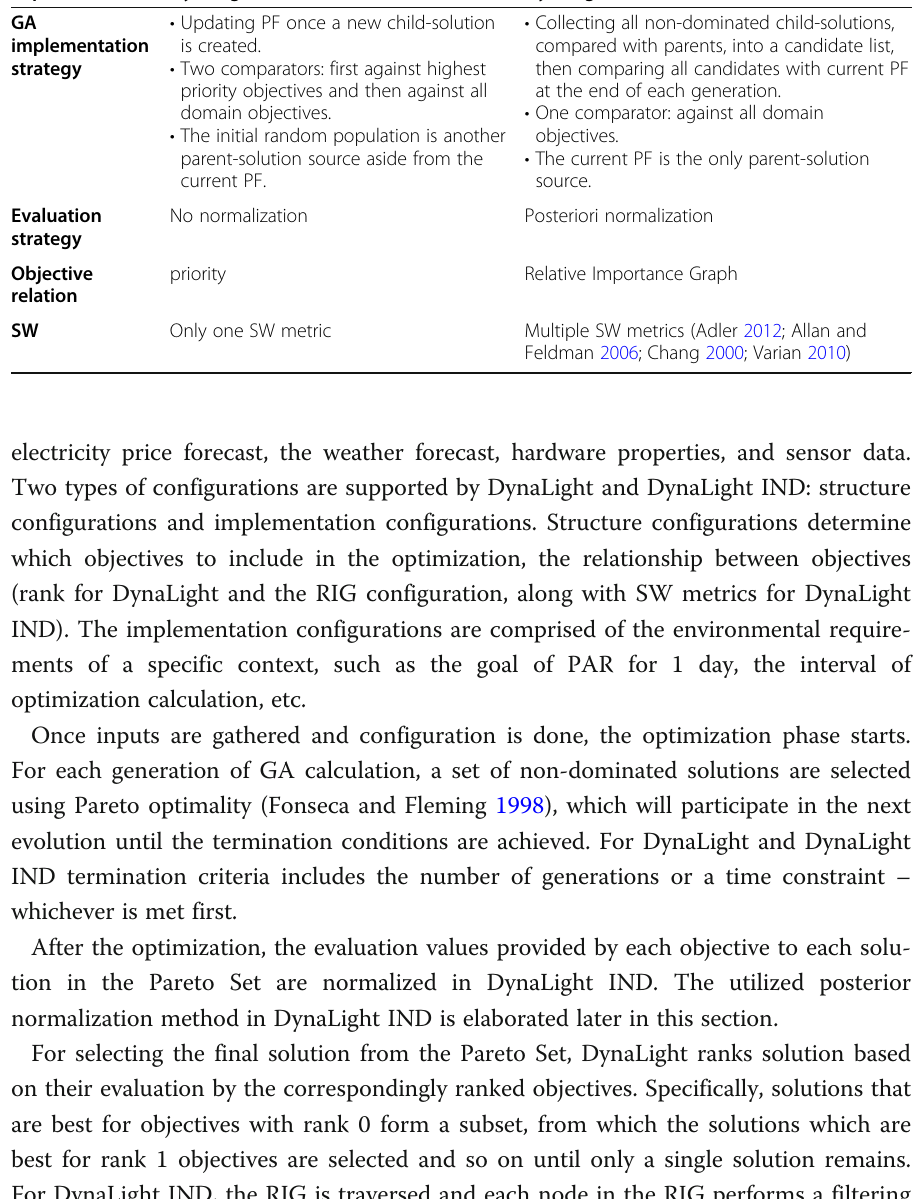
Table 1 The comparison of the two versions Aspect